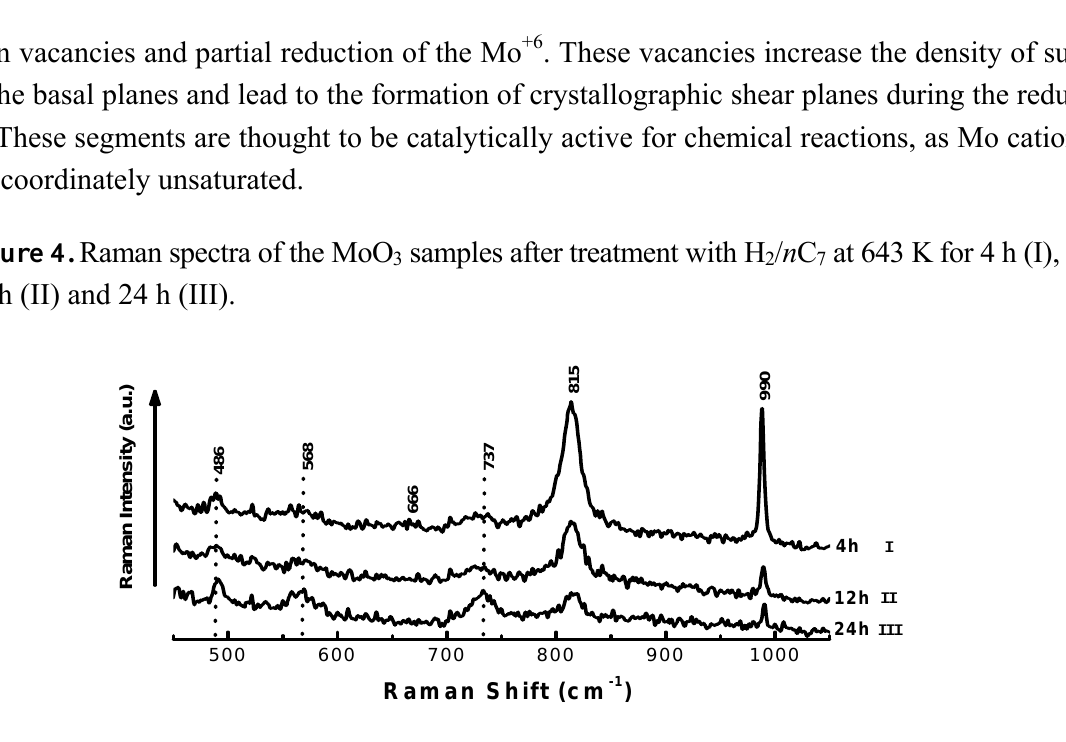
samples after treatment with H 3